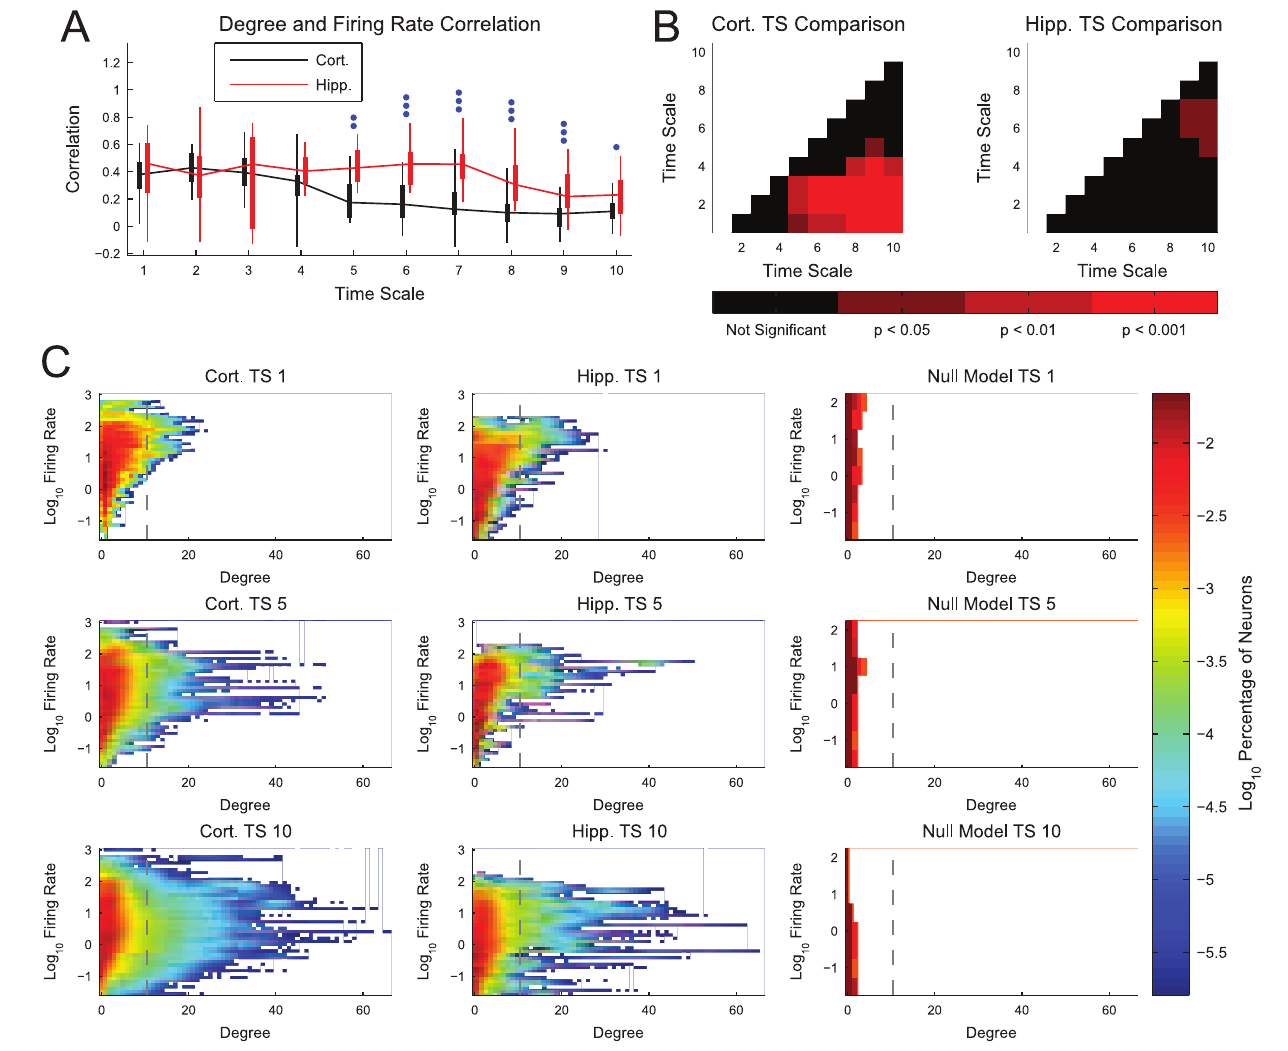
Fig. 3. Firing rate and degree were correlated. ( A ) Neuron firing rate and degree were correlated, especially for short time scales. Hippocampal networks showed higher correlations than cortical networks for middle and long time scales. Box plots: minimum, 25 th percentile, median, 75 th percentile, maximum data set (recording). Differences between hippocampal and cortical networks were assessed with a multiple comparisons corrected Mann-Whitney Test (one dot: p , 0.05, two dots: p , 0.01, three dots: p , 0.001). ( B ) The correlation between firing rate and degree generally decreased with time scale. Multiple comparison corrected Mann-Whitney Test p-values between different time scales for the same tissue type. ( C ) Density plots of neuron degrees and firing rates in sub-networks. Note that the real data contain many high degree neurons and the stronger correlation between degree and firing rate for short time scales (top row) in comparison to longer time scales. Also, note that the null model data contained very few non-zero degree neurons. This lack of connectivity in the null model implies that high degrees for high firing rate neurons are not the result of false-positive connections. Vertical line is the approximate degree threshold for hub